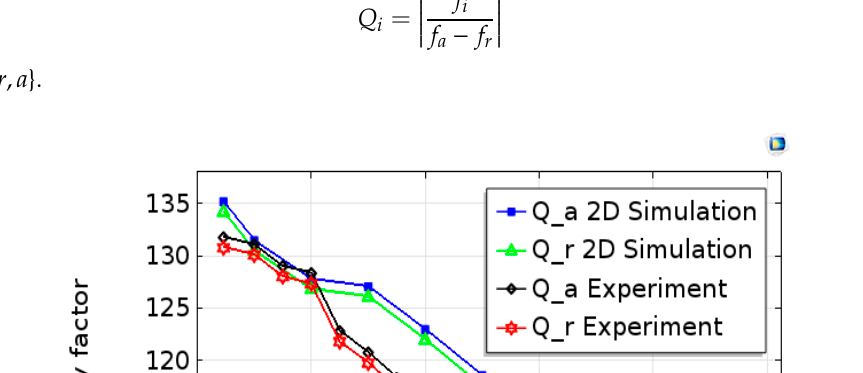
Figure 7. Evolution of experimental and simulated electromechanical coefficients versus temperature.